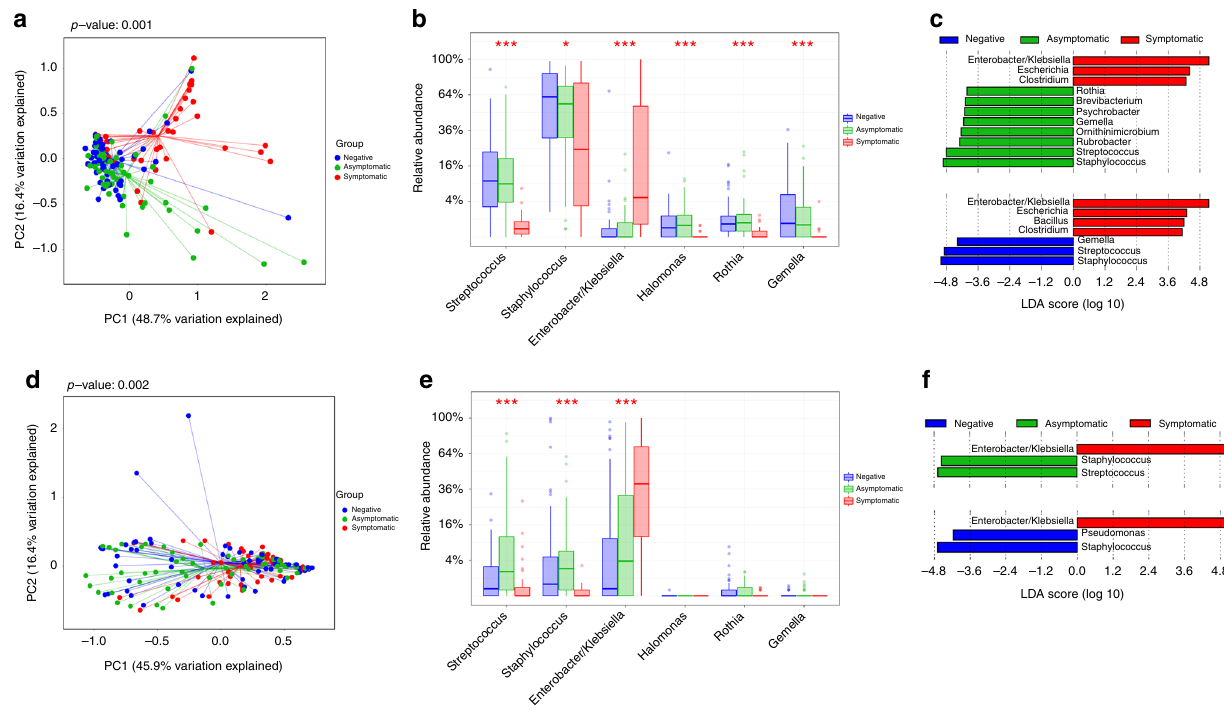
Fig. 4 Breast milk and infant stool microbiome are associated with symptomatic infection. Weighted UniFrac principal coordinate analysis (PCoA) of breast milk microbiome show signi fi cant differences between milk from mothers of symptomatic neonates when compared to mothers of asymptomatic and rotavirus negative neonates ( a ). Bar plots show the relative abundance and signi fi cance of the most signi fi cant bacteria genera in breast milk. The center line denotes the median, the boxes cover the 25th and 75th percentiles, and the whiskers extend to the most extreme data point, which is no more than 1.5 times the length of the box away from the box. Points outside the whiskers represent outlier samples ( b ). Linear discriminant analysis (LDA) effect size (LEfSe) of bacterial genera corroborate these fi ndings ( c ). Similar data are shown for infant fecal microbiome with PCoA in d , relative abundance in e , and LEfSe analysis in f . For relative abundance studies, * p < 0.05 and *** p < 0.001 are statistically signi fi cant based on Kruskal – Wallis test with FDR. For LEfSe analysis, genera with an LDA cutoff of 4.0 and signi fi cance threshold of 0.05 are